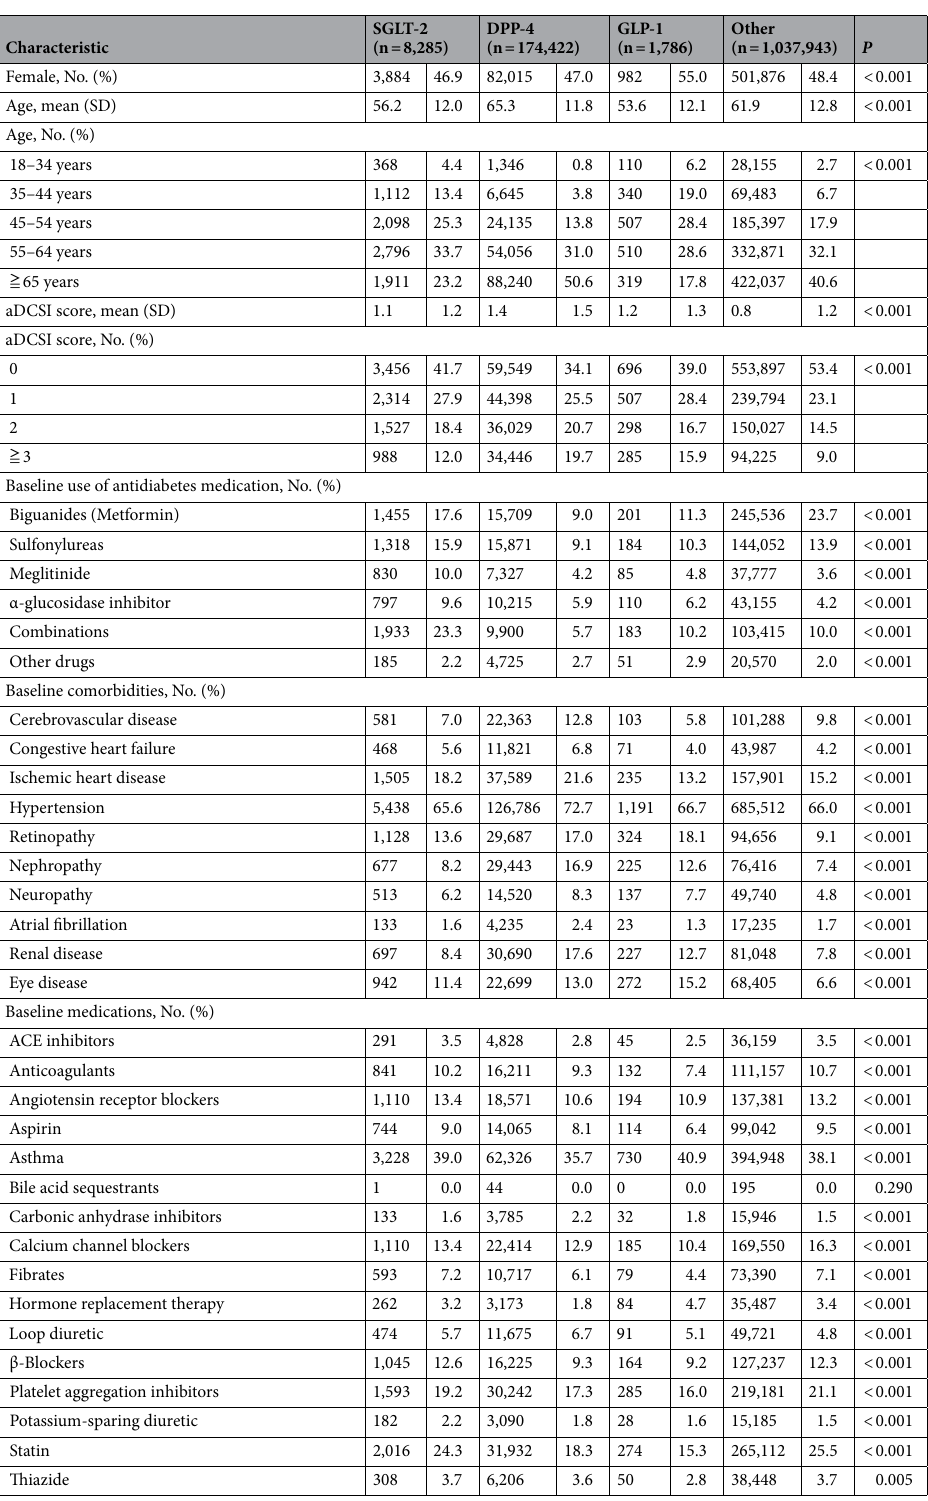
Table 1. Characteristics of the study sample from first cohort. ACE, angiotensin-converting enzyme; aDCSI, adapted Diabetes Complications Severity Index; DPP-4, dipeptidyl peptidase 4; GLP-1, glucagon-like peptide 1; SD, standard deviation; SGLT-2, sodium-glucose cotransporter